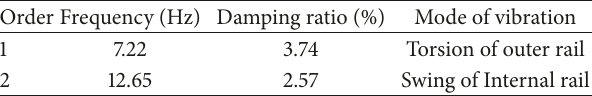
Table 1: Natural frequency and damping coefficient.